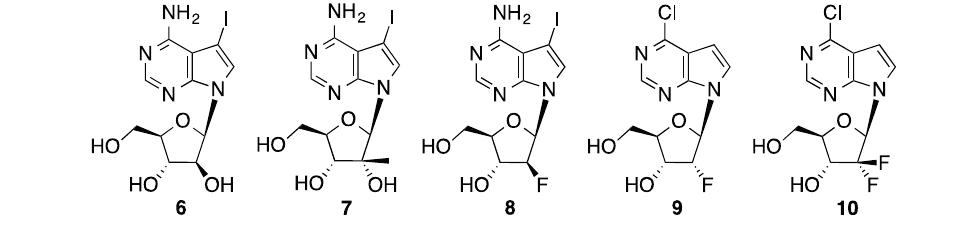
Figure 3. Sugar-modified purine